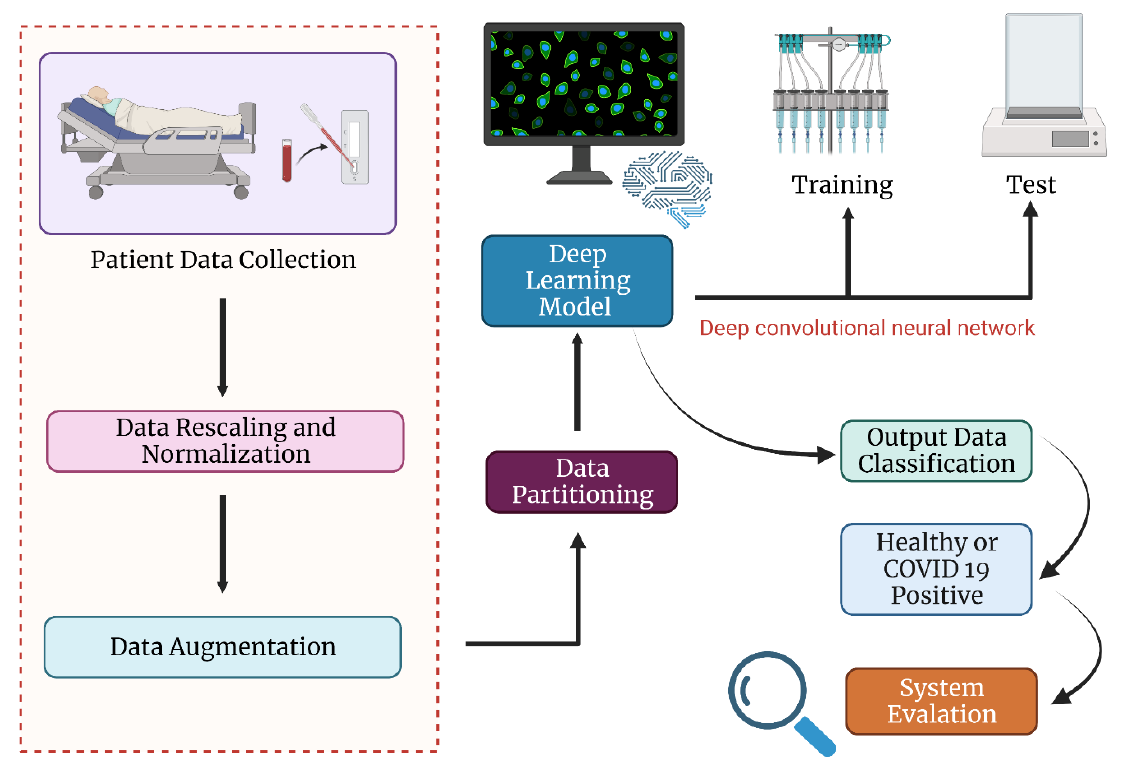
Figure 2. Deep learning techniques for the diagnosis of novel coronavirus.